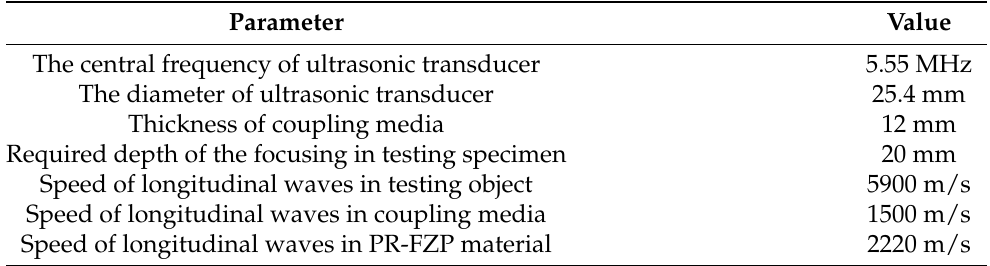
Table 1. Parameters of planned ultrasonic